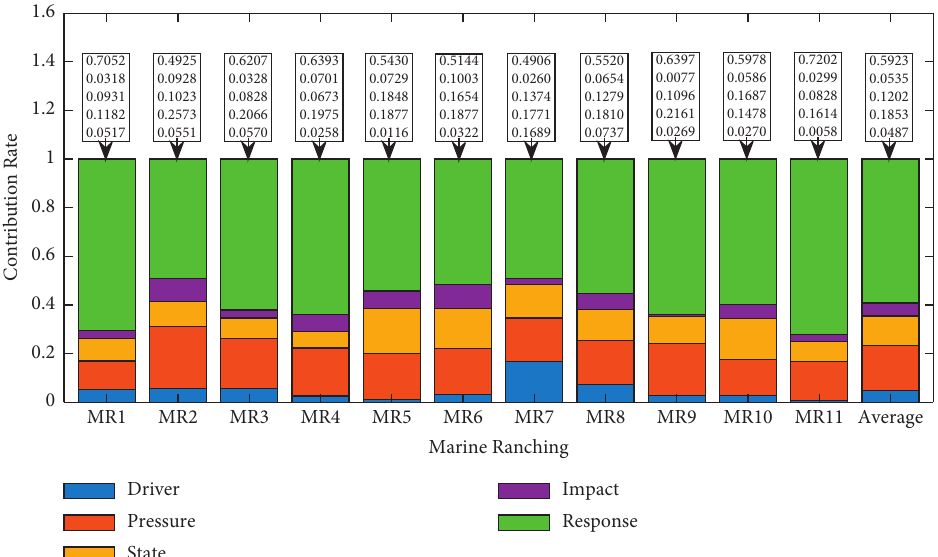
Figure 6: Contribution rates of clusters for